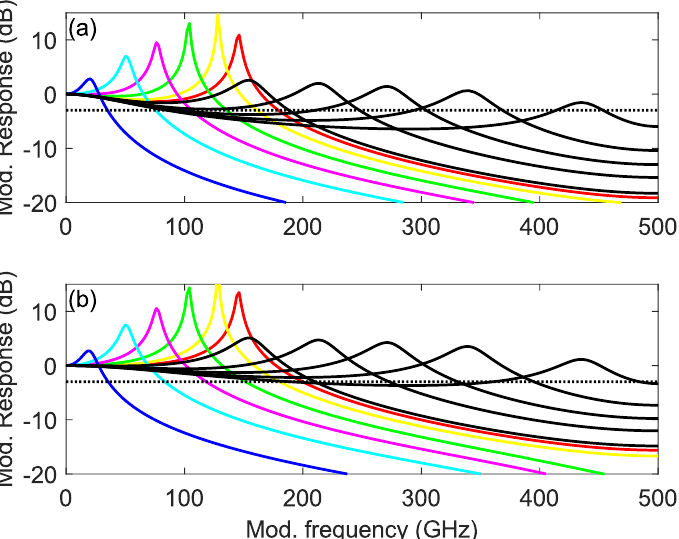
Figure 6. Small signal polarization modulation response for spin injection modulation of the LC- VCSEL according to Equation (17) and for different LC-voltage: U = 0.493 V ( γ p = 7.5 GHz)—blue color; U = 0.49 V ( γ p = 116 GHz)—cyan color; U = 0.487 V ( γ p = 211 GHz)—magenta color; U = 0.483 V = ( γ p = 310 GHz)—green color; U = 0.477 V ( γ p = 404 GHz)—yellow color; U = 0.465 ( γ p = 468 GHz)—red color. The black color curves correspond to (from left to right) U = 0.506 V ( γ p = − 607 GHz), U = 0.51 V ( γ p = − 811 GHz), U = 0.514 V = ( γ p = − 1012 GHz), U = 0.519 V ( γ p = − 1253 GHz), U = 0.527 V ( γ p = − 1610 GHz). The straight dotted lines show the level